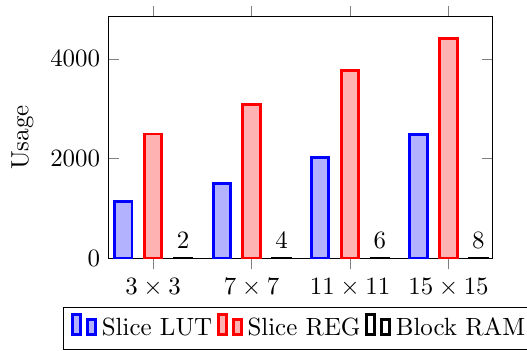
Figure 8. Resource usage for the SCoG module with four different filter sizes. Contributing resources for each filter size include Slice LUT, Block RAM, and Slice